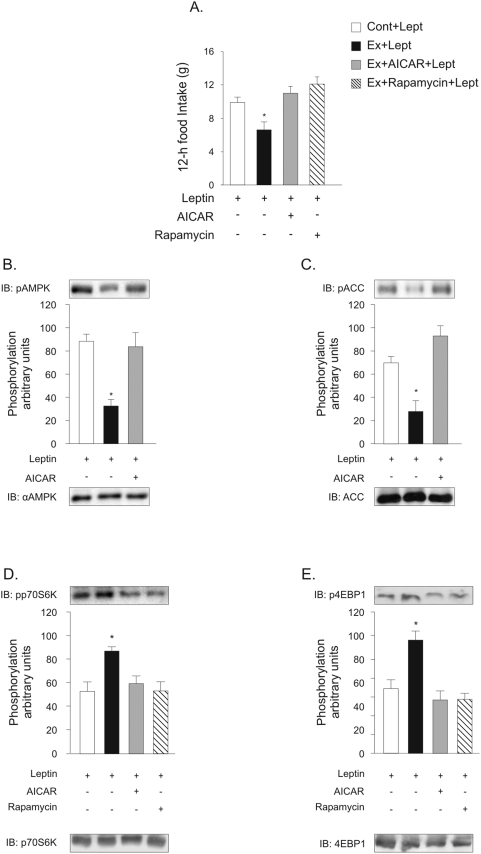
Blocking effects of AICAR and Rapamycin on leptin-induced anorexia.(a) Effect of i.c.v. administration of leptin on exercised rats; pretreatment with AICAR or Rapamycin (n = 8–10 animals per group). (b, c, d, e) Representative Western blots of five independent experiments showing hypothalamic lysates from Wistar rats. Phospho-AMPKthr172, threonine-phosphorylated AMPK and total AMPK (b); phospho-ACCser79, serine phosphorylated ACC and total ACC (c); phospho-p70S6Kinasethr389, threonine phosphorylated p70S6Kinase and total p70S6K (d); phospho-4EBP1thr70, threonine phosphorylated 4EBP1 and total 4EBP1 (e). Data are the means±SEM. *p<0.05, vs. other groups.